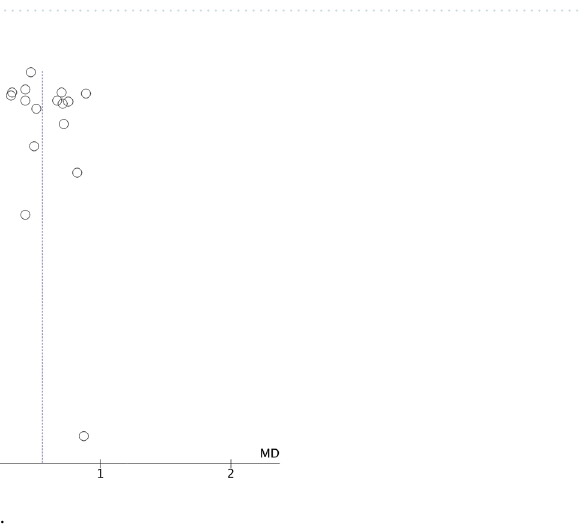
Figure 6. Results and summary statistics of studies analysing uric acid levels in men with and without metabolic syndrome (MetS) (meta-analysis 2).